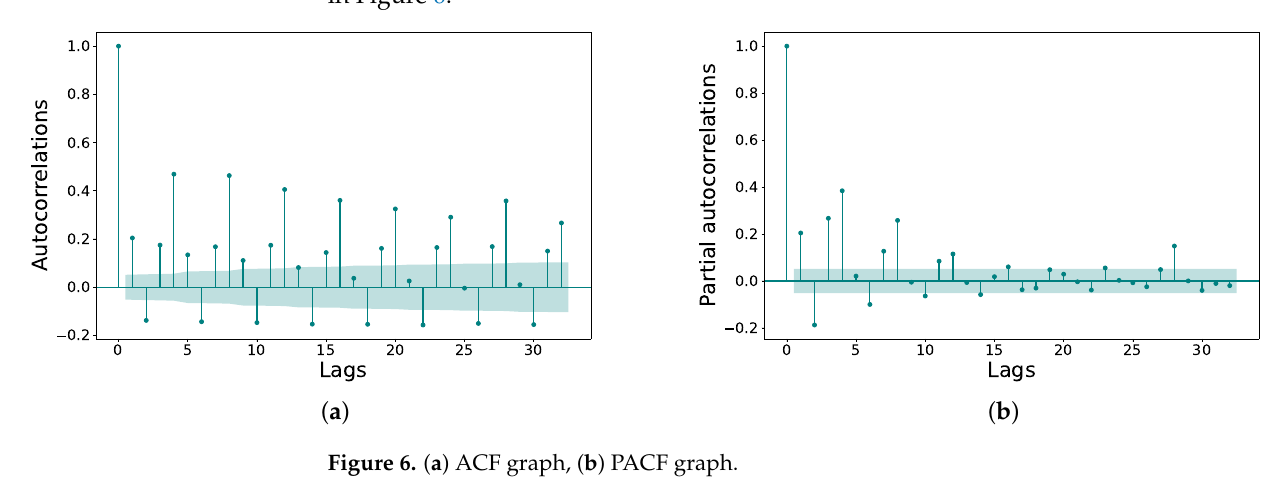
Figure 6. ( a ) ACF graph, ( b ) PACF graph.